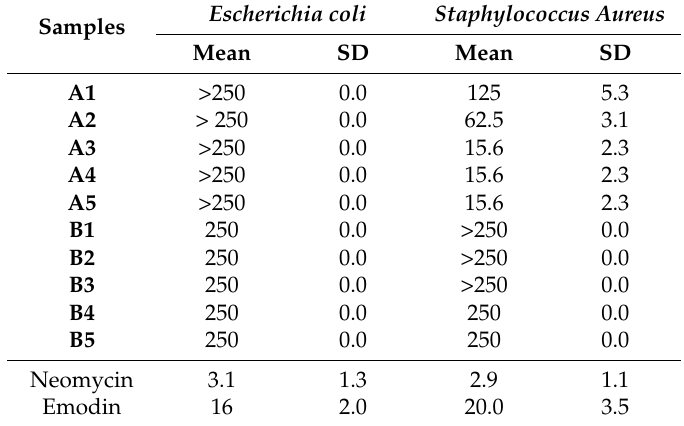
Table 5. The minimal inhibitory concentration (MIC/ µ g · mL − 1 ) of the tested ILs in the A and B